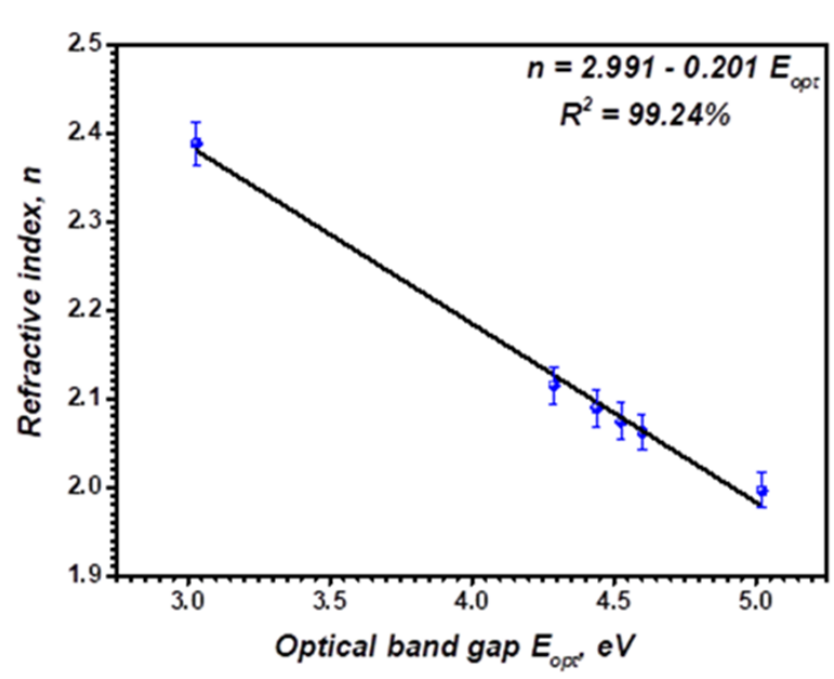
Figure 12. Variation of refractive index, n optical energy gap, E opt blend, and Bi-blend hybrid films